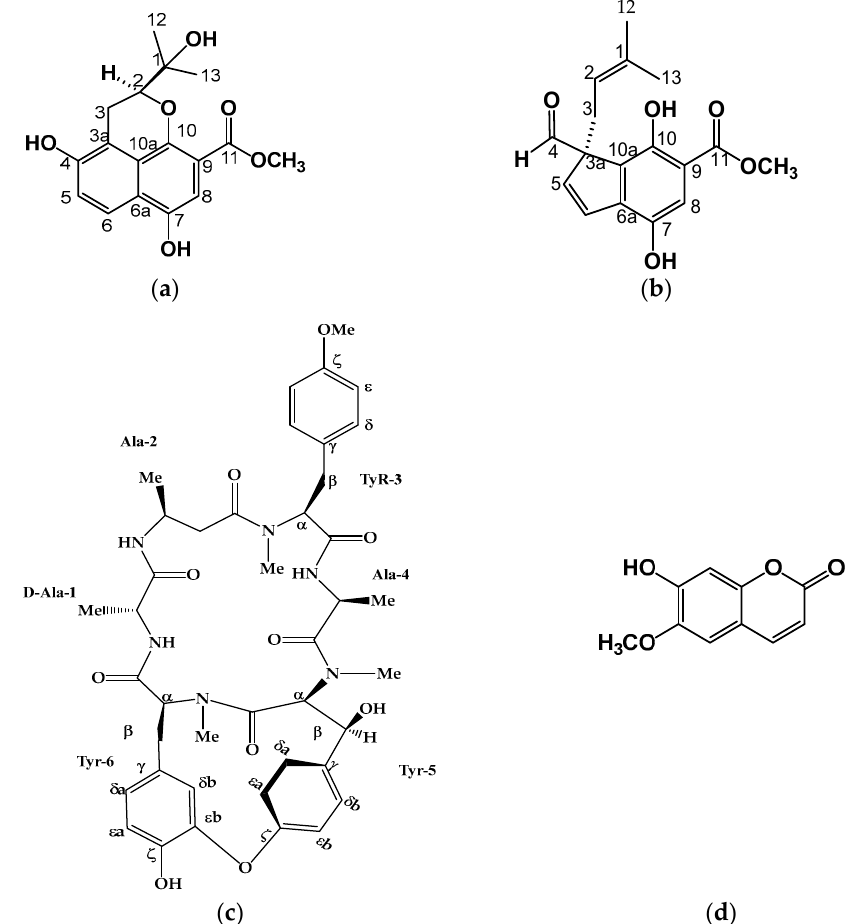
Figure 2. Compounds isolated and characterized from the roots of Bouvardia ternifolia : ( a ) ternifoliol ( 1 ); ( b ) ternifolial ( 2 ); ( c ) bouvardin ( 3 ); ( d ) scopoletin ( 4 ). Table 1. 1 H-NMR and 13 C-NMR spectroscopy data of 1 (CD 3 OD, 400 MHz) and 2 (DCl 3 , 600 MHz). Position